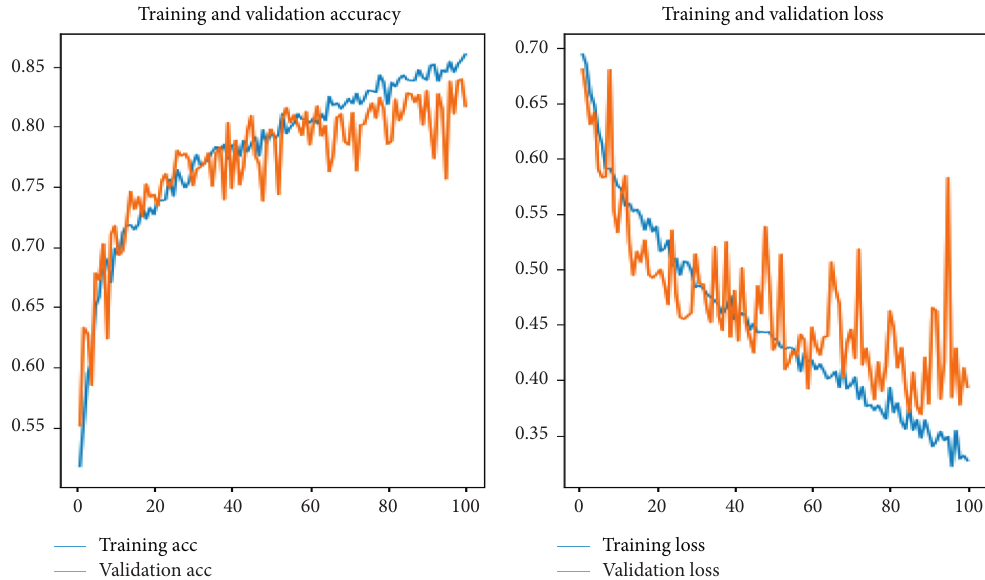
Training loss Validation